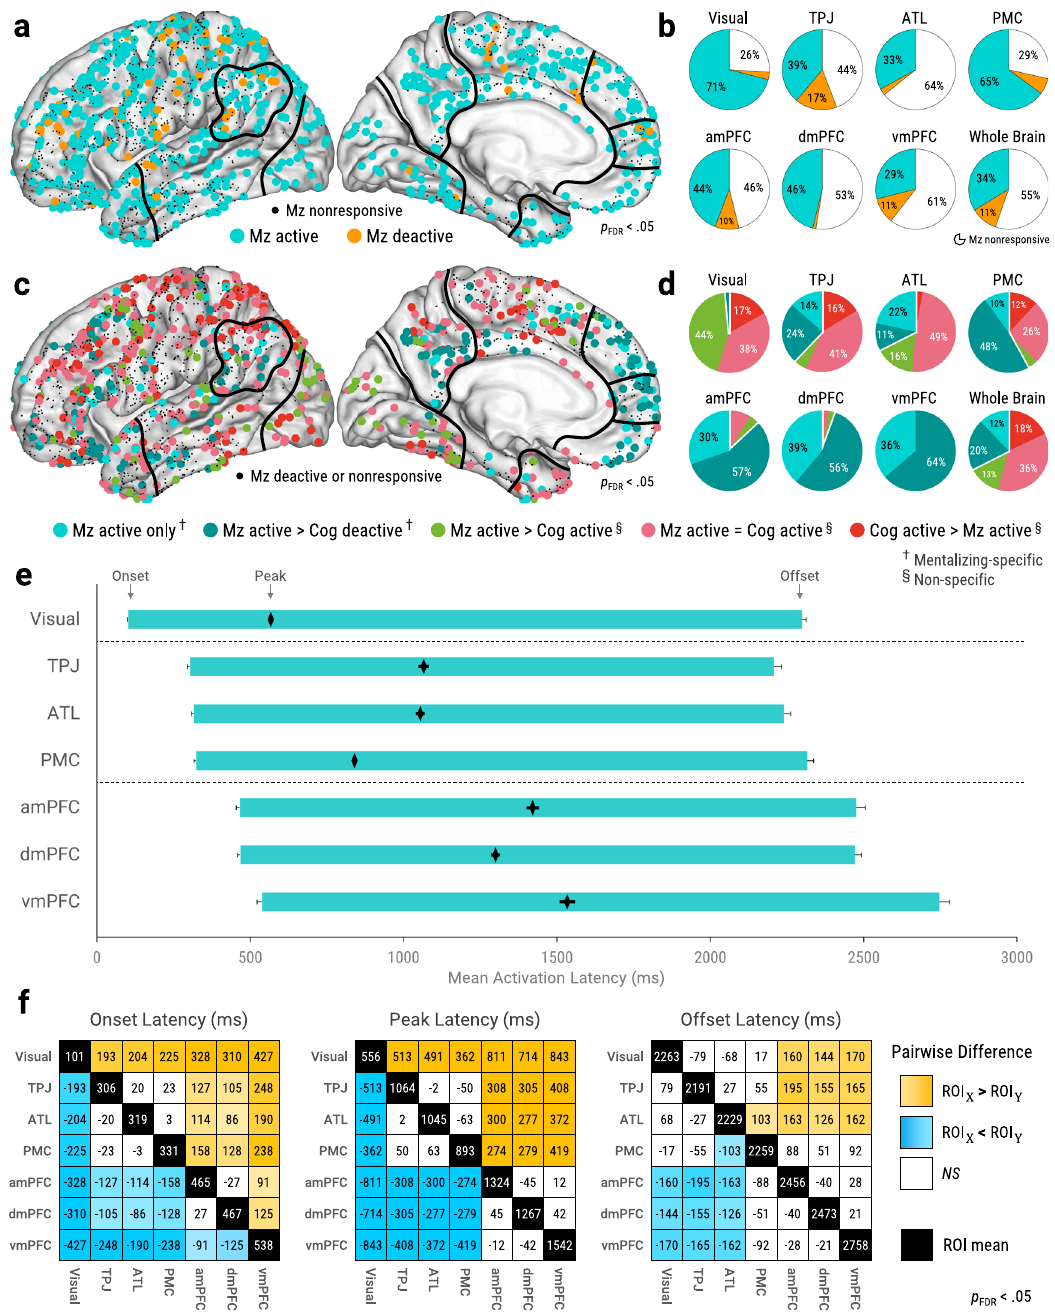
Fig. 3 A neurocognitive sequence for mentalizing. Brain maps plot all sites on left hemisphere with approximate ROI outlines (full views in Supplementary Figs. 6 and 7). a , b Sites identi fi ed as active, deactive, or nonresponsive for mentalizing versus baseline (see Figs. 1f and 2; p FDR < 0.05, corrected across timepoints and sites). c , d Functional speci fi city of mentalizing-active sites. † Mentalizing-speci fi c sites, de fi ned as mentalizing-active but not cognitive- active ( p FDR < 0.05, corrected across timepoints and sites) with signi fi cantly higher peak power for mentalizing ( p FDR < 0.05, corrected across sites). § Non- speci fi c sites, de fi ned as mentalizing-active and cognitive-active. e Mean ROI activation latencies. Left and right fl oating bar edges depict onsets and offsets, respectively, while diamonds depict peaks (see Fig. 1e). Error bars depict standard error of the mean. f Pairwise ROI comparisons of activation latencies. Black diagonal squares show ROI means. Off-diagonal squares show estimates for ROI X - ROI Y (controlled for behavioral response times). Orange and blue squares indicate signi fi cant differences; color intensity indicates effect size ( p FDR < 0.05, corrected across unique ROI pairs). White squares indicate nonsigni fi cant ( NS ) differences. Pairwise comparisons used linear mixed-effect models restricted to participants with mentalizing-active sites in both ROIs (nested within Trial within Participant). See Table 1 for n of panels e , f . Abbreviations : Mz = mentalizi n g (collapsed across self and other), Cog = cognitive task (arithmetic), Visual = visual cortex, ATL = anterior temporal lobe, TPJ = temporoparietal junction, PMC = posteromedial cortex, amPFC = anteromedial prefrontal cortex, dmPFC = dorsomedial prefrontal cortex, vmPFC = ventromedial prefrontal cortex, Whole Brain = all relevant sites in cortex, ROI = region-of-interest. Source data are provided as a Source Data fi le.